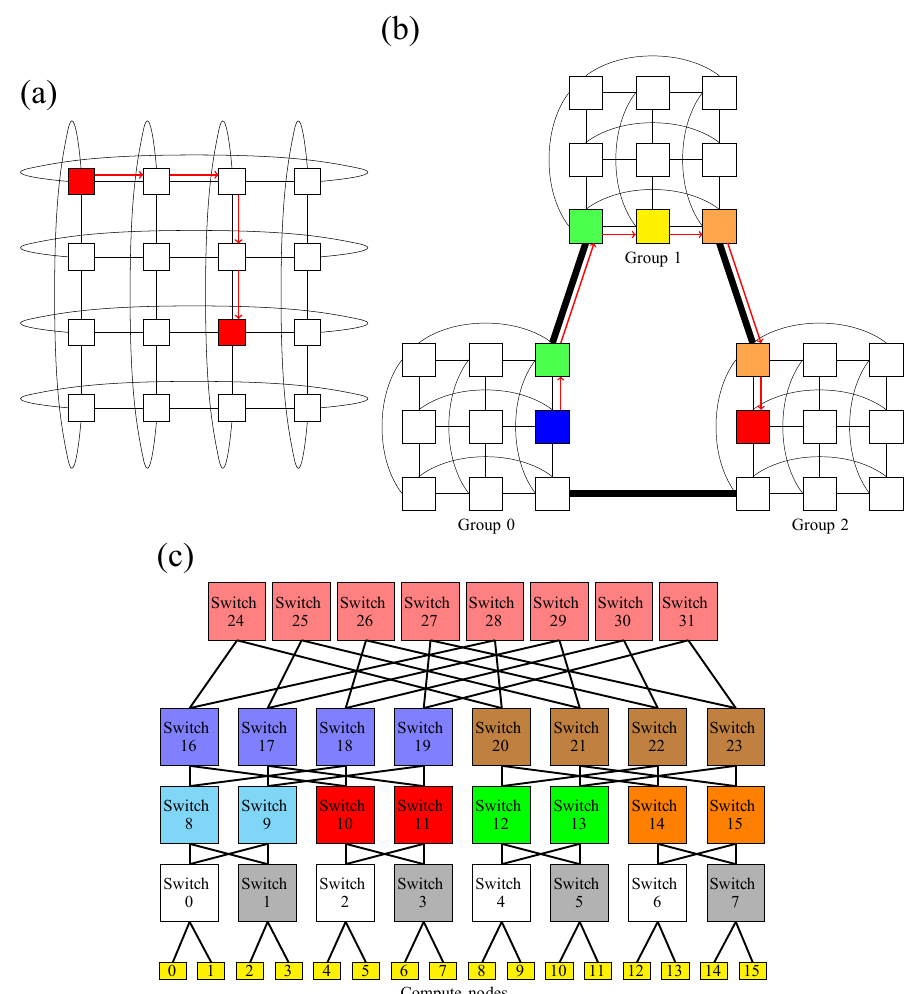
Figure 2. Topology illustration: (a) , (b) , and (c) are the torus, dragonfly, and fattree topologies, respectively. Adapted from SNL (2017).